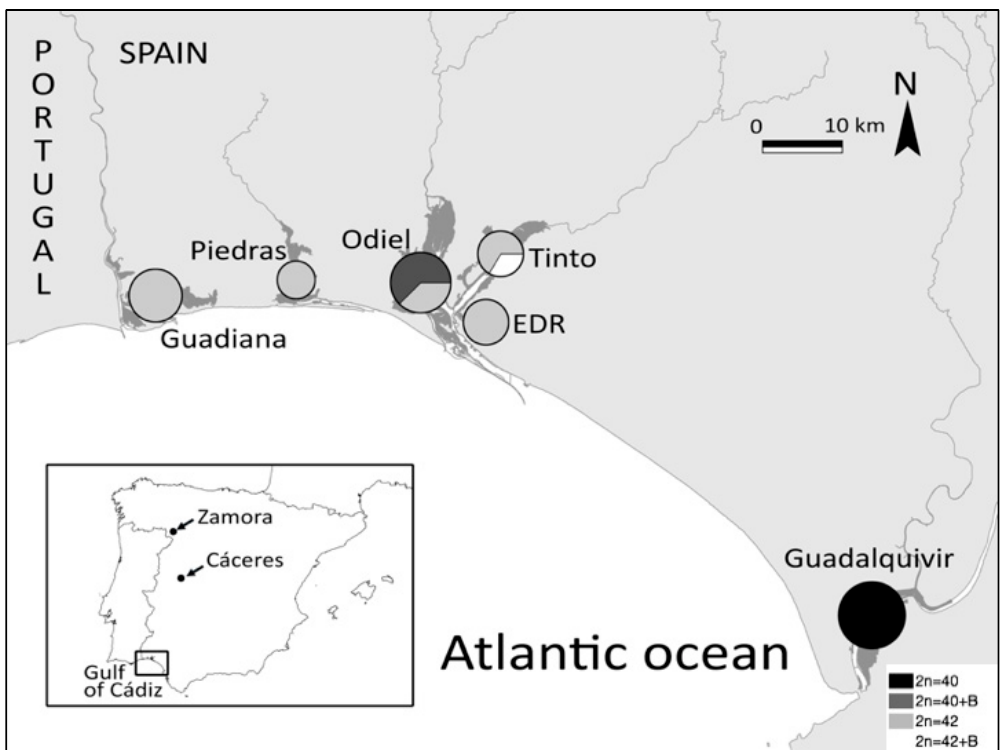
Figure 1. Study area and populations of C. suaveolens sampled in the tidal marsh (dark gray) of the Gulf of Cádiz, Southwestern Iberia. The individuals of Cáceres and Zamora are shown in the inset map. The sampling locations and diploid numbers are shown as pie charts. The size of each chart indicates the number of individuals sampled, which ranged between 5 and 8 individuals, in each location.